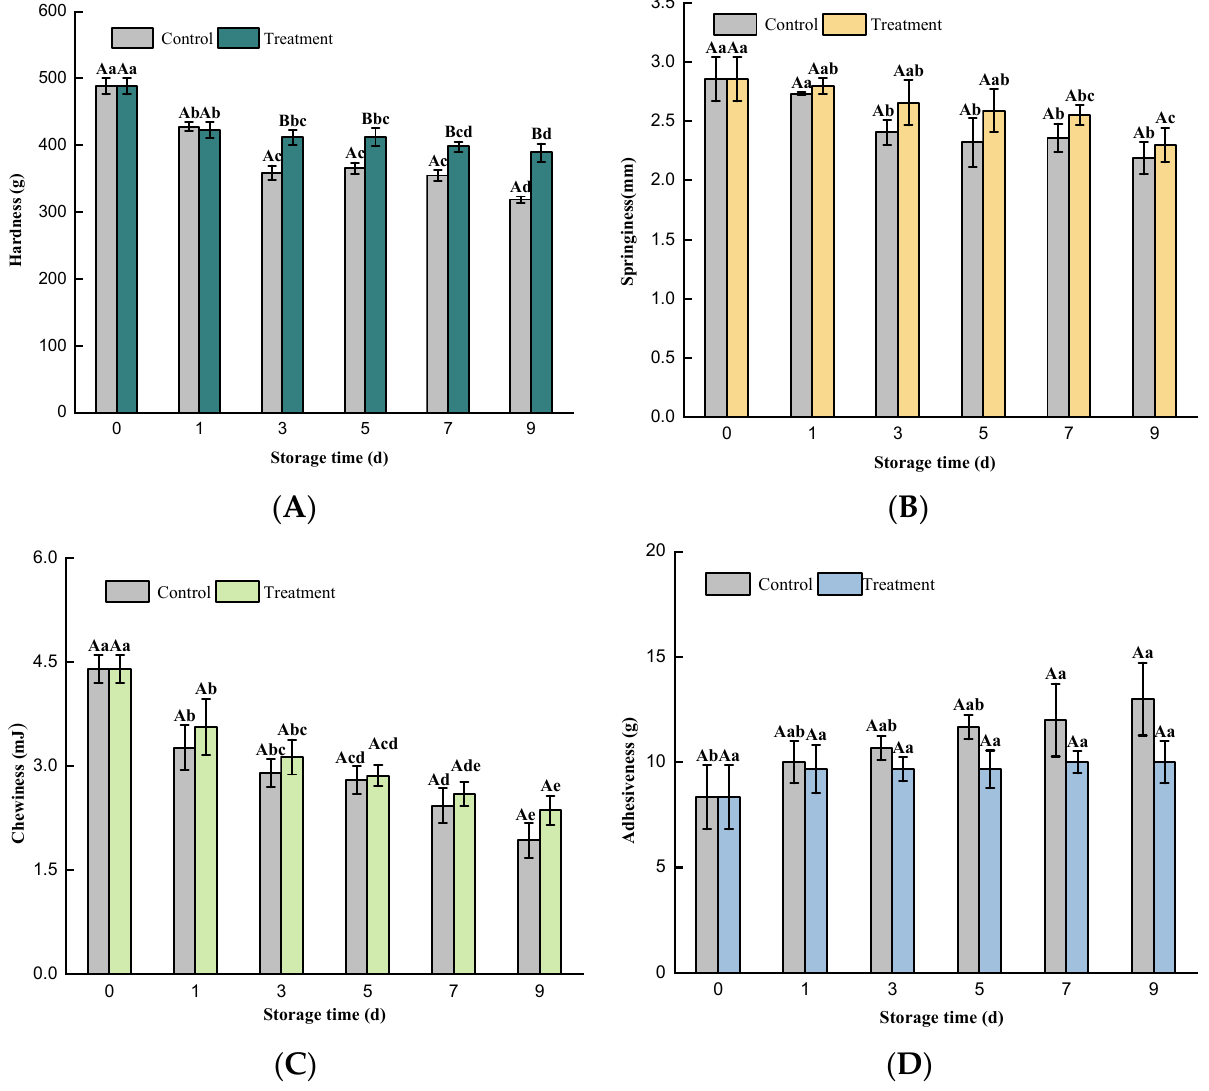
Figure 4. Changes in the hardness ( A ), springiness ( B ), chewiness ( C ), and adhesiveness ( D ) of Trachinotus ovatus during refrigeration. Within the same group, different lowercase superscripts indicate significant differences ( p < 0.05); Different capital letters indicated significant differences ( p < 0.05) between the treatment and control groups at same storage time. With the extension of the refrigeration time, the elasticity and chewiness of the samples showed a decreasing trend (Figure 4B,C). The HVACP treatment group was significantly lower ( p < 0.05) than that of the control group. During the storage, the microorganisms in fish were inhibited effectively by RONS, which may reduce the activities of actomyosin and Ca 2+ , and the reduction in the salt-soluble protein in meat [38]. This is helpful to with plasma-activated water combined with ginger extract and found that the texture